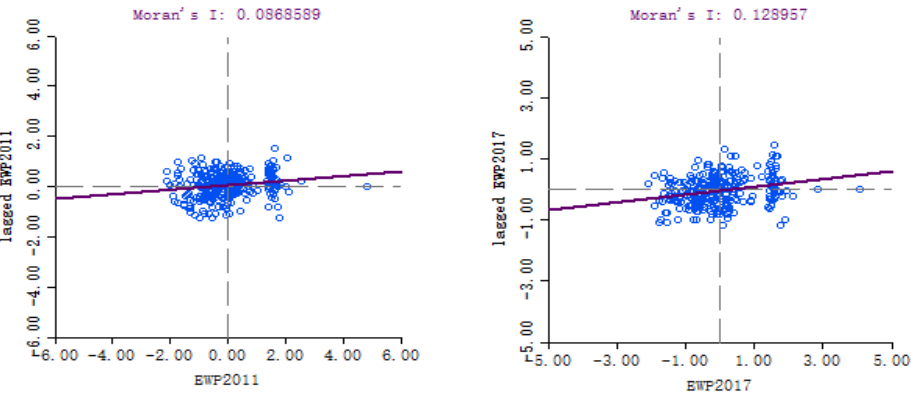
Figure 6. Moran scatter plots of the EWP in 2011 ( left ) and 2017 ( right ).